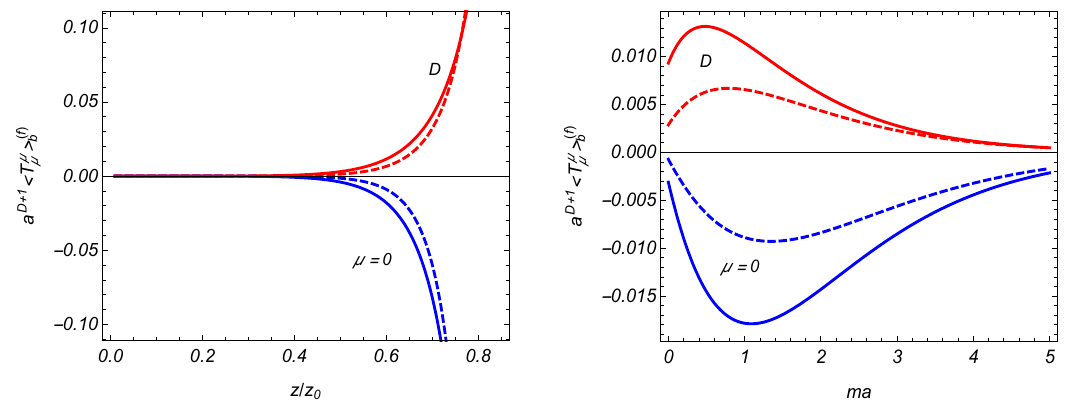
Figure 5. The same as in Figure 1 for the L-region. The left and right panels are plotted for ma = 1 and z / z 0 = 0.6,